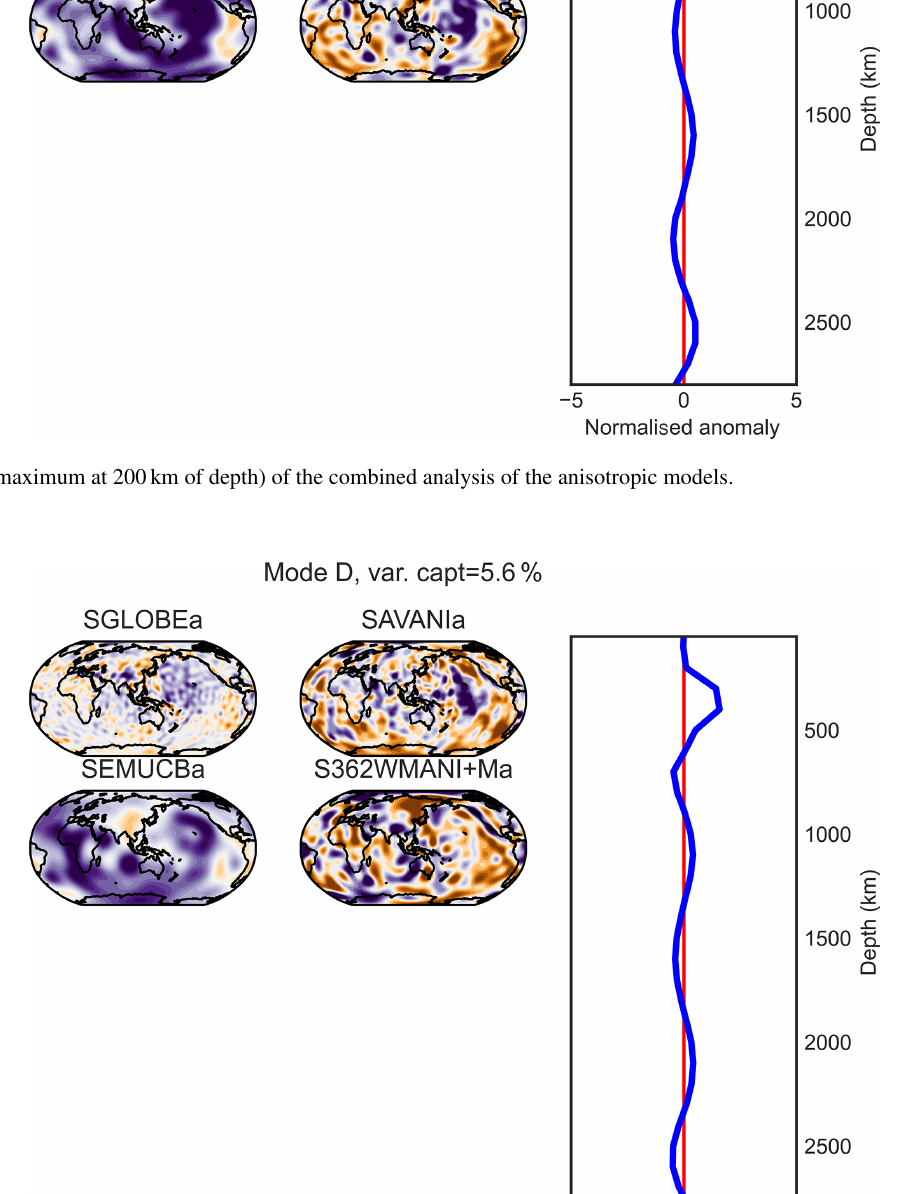
Solid Earth, 12, 1601–1634, 2021